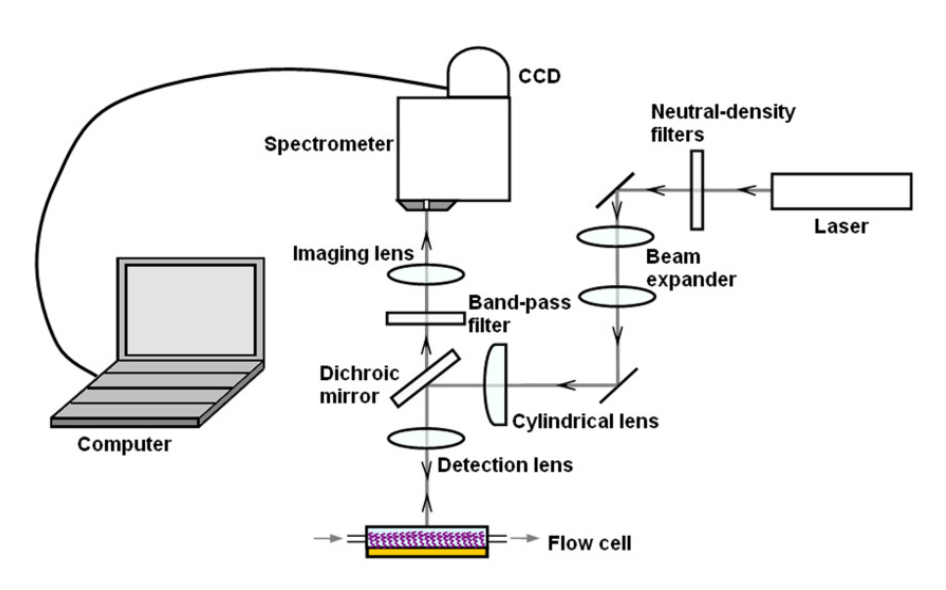
Figure 1. Schematic representation of this line-monitoring, hyperspectral fluorescence setup.